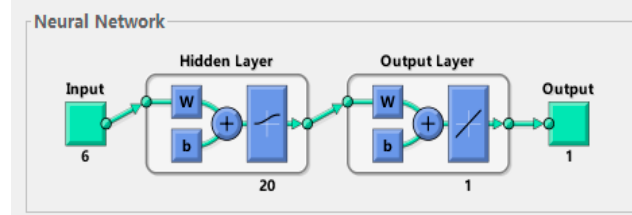
Figure 7. BP neural network topology.